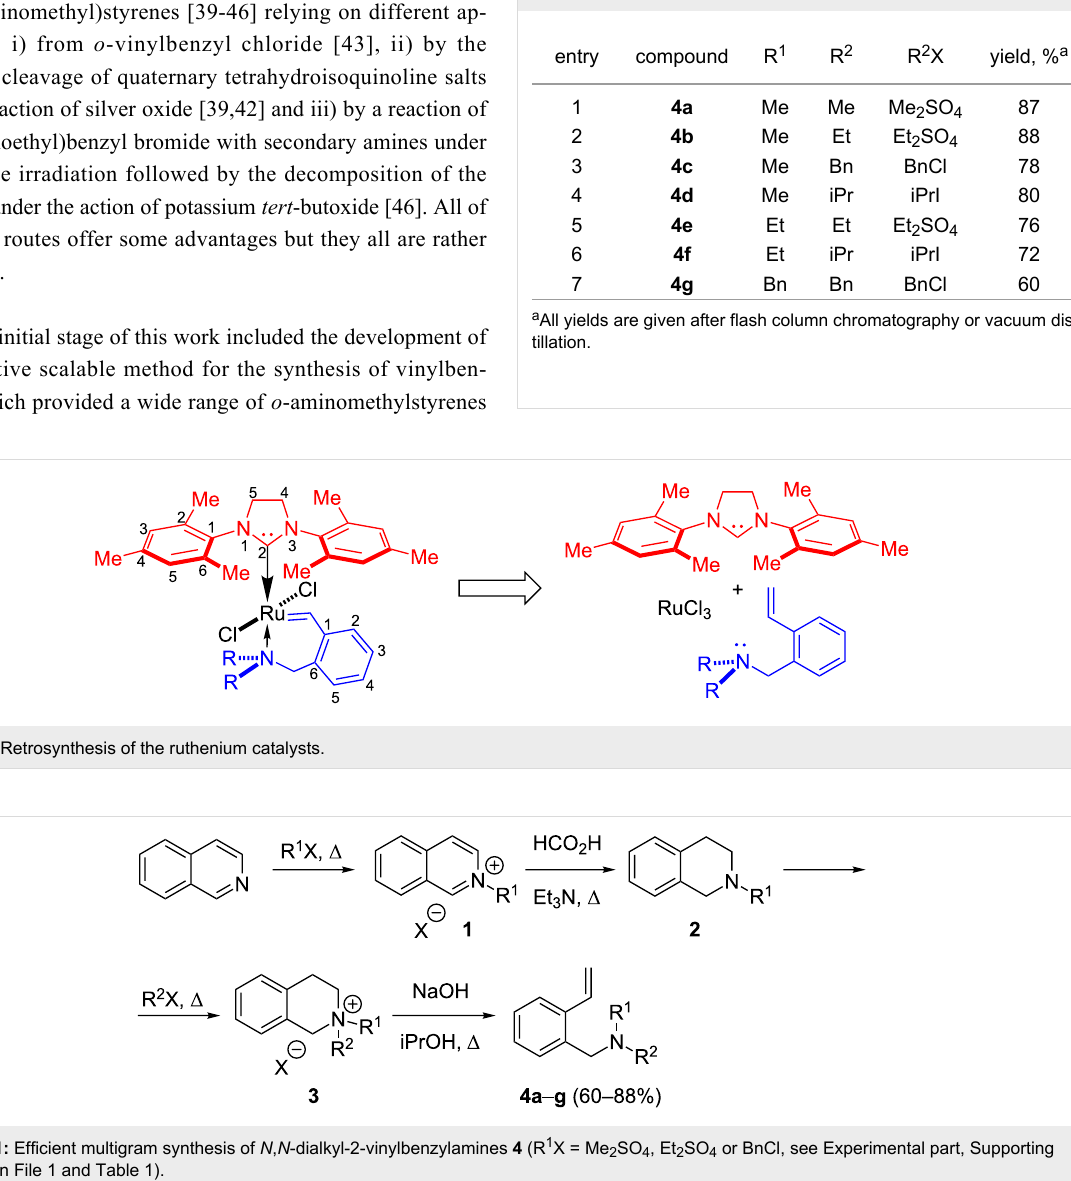
Table 1: Yields of target 2-vinylbenzylamines 4 after four